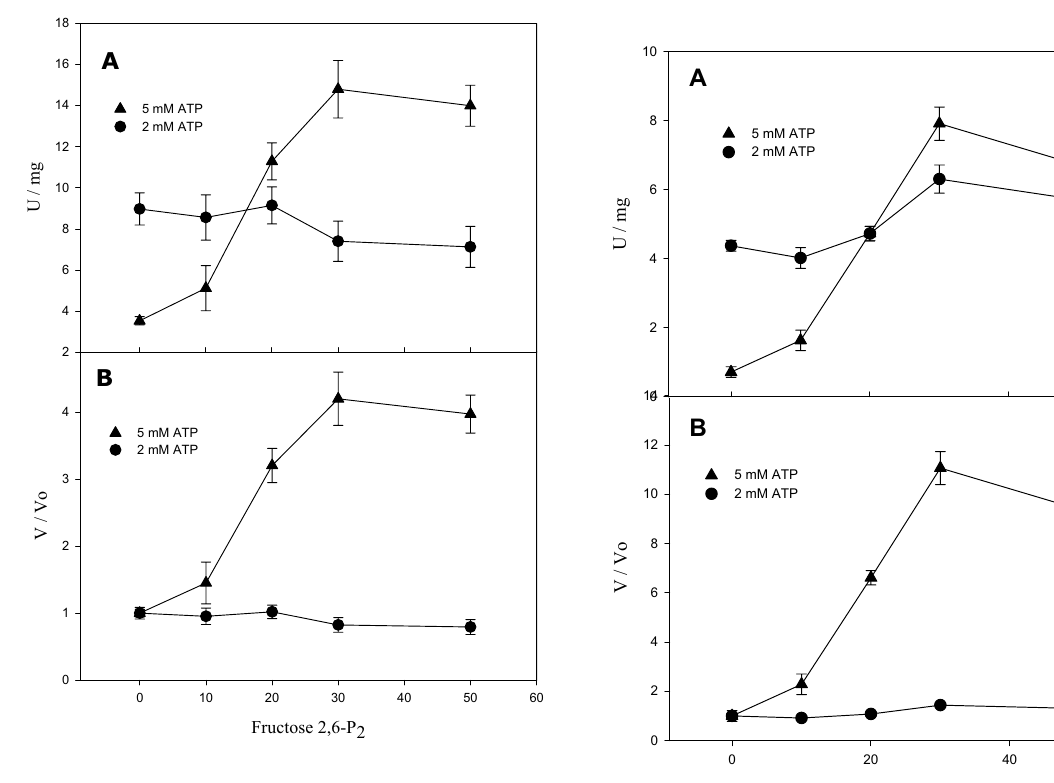
Fig. 7 – Effects of fructose 2,6-bisphosphate on PFK activity from flightmusclehomogenate. PFKactivitywasmeasuredasdescribedon Materials and Methods, in the presence of 5 mM fructose 6-phosphate andATPasindicated. Valuesaremeans ± SEofatleastsixindependent experiments. Panel A: relative activity. Panel B: activity normalized by initial velocity (V 0 ) in the absence of the modulator.